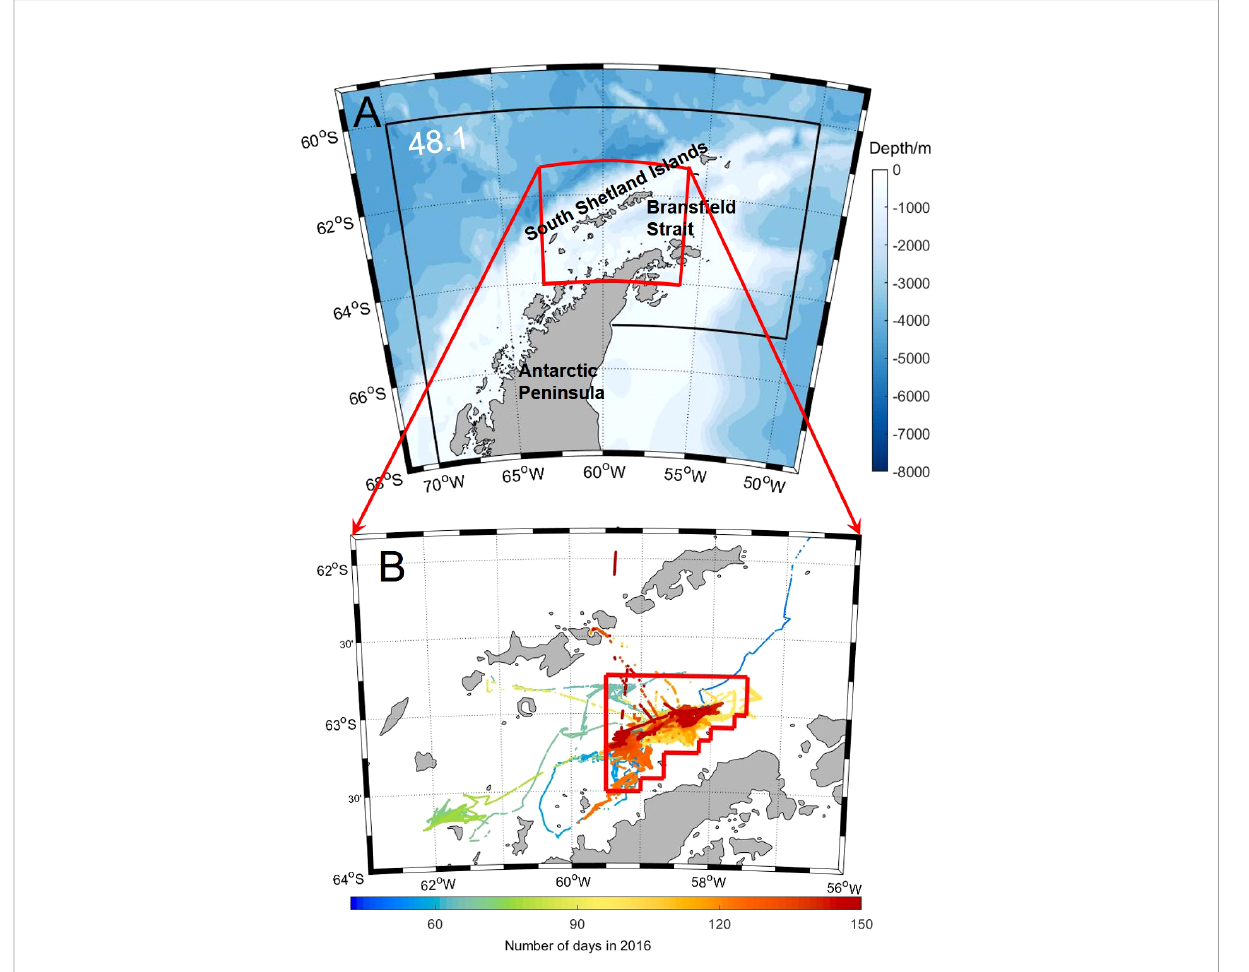
FIGURE 2 Study area: (A) CCAMLR Subarea 48.1 topography, (B) : F/V Fu Rong Hai track lines, February – May 2016 (color intensity indicates number of days). The red polygon denotes area within grid 59.50 – 57.75°W, 63.50 – 62.90°